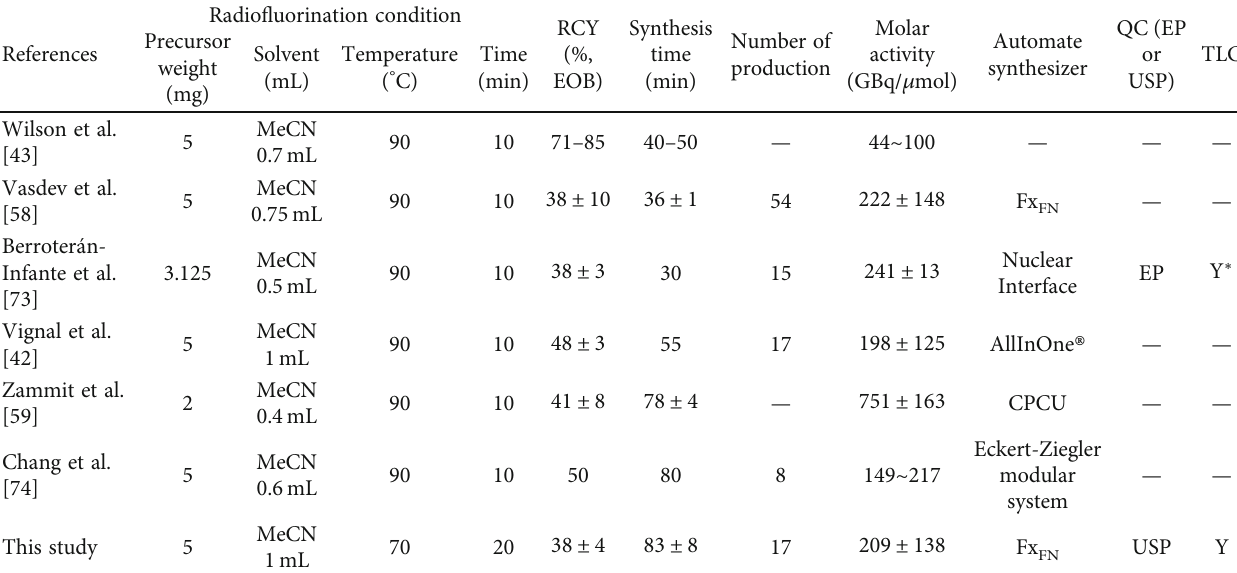
Table 4: Synthesis of the [ 18 F]FEPPA (2) via various methods.